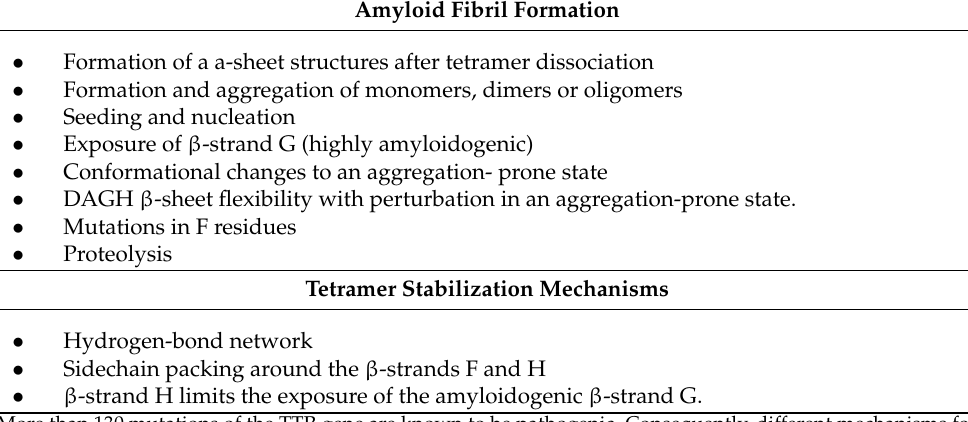
Table 1. Mechanisms of amyloid formation or